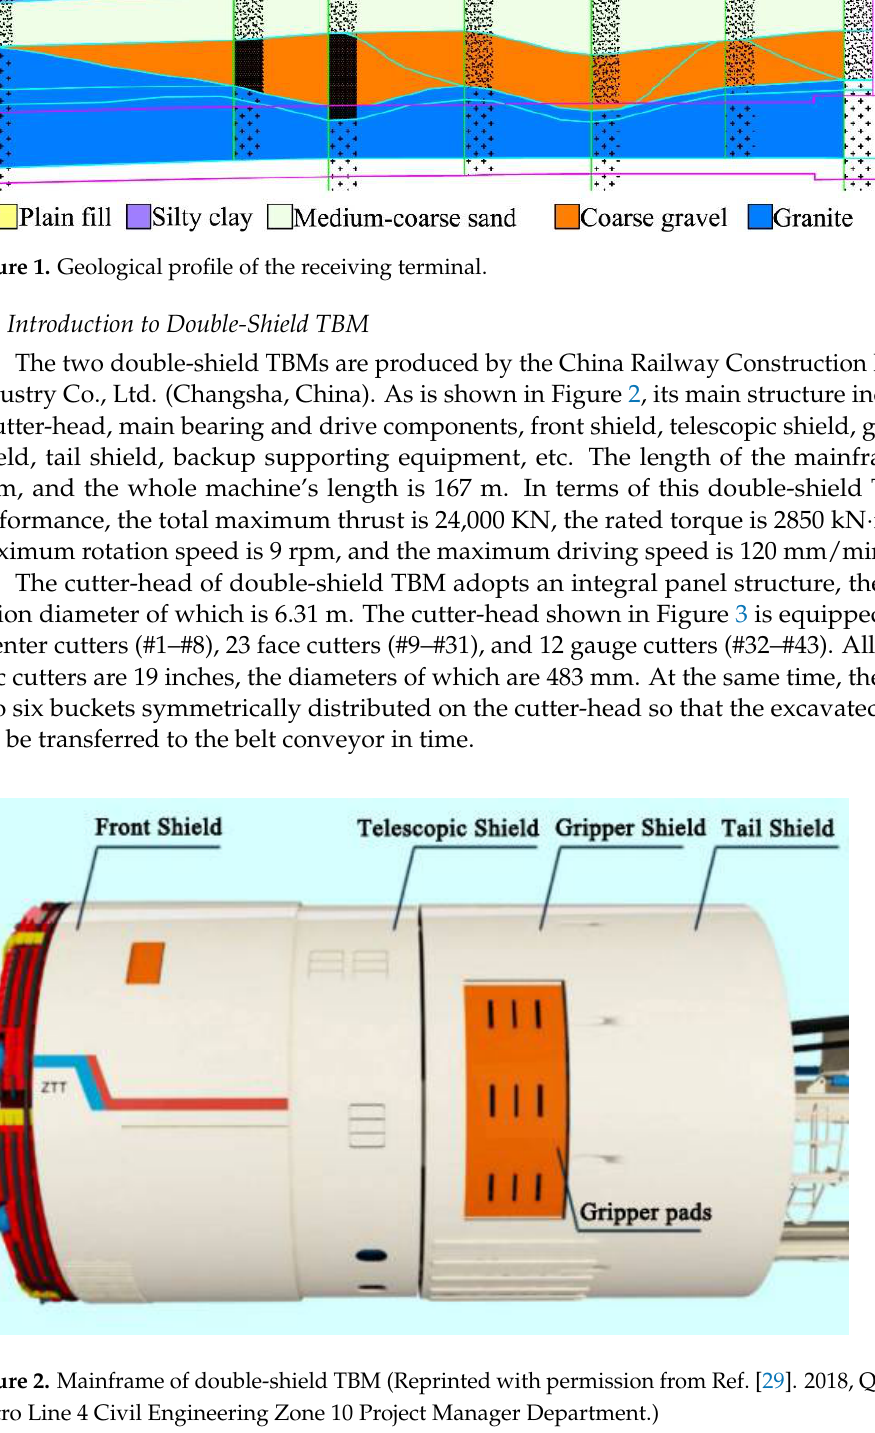
Figure 1. Geological profile of the receiving terminal.